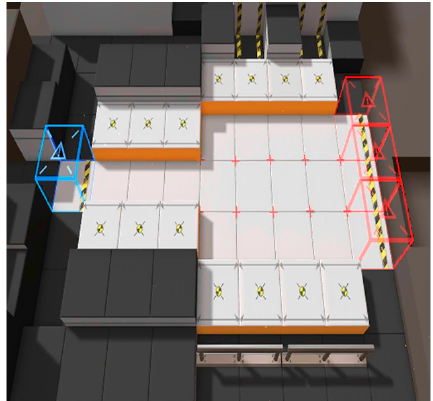
Figure 2. An example of a game map obtained from Arknights via Unity Hub.